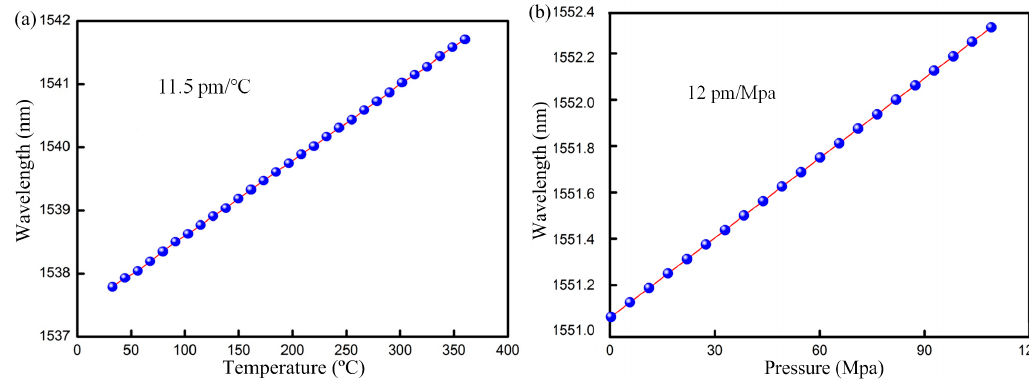
Figure 11. FBG sensor peak wavelength versus ( a ) Temperature; ( b ) Pressure.